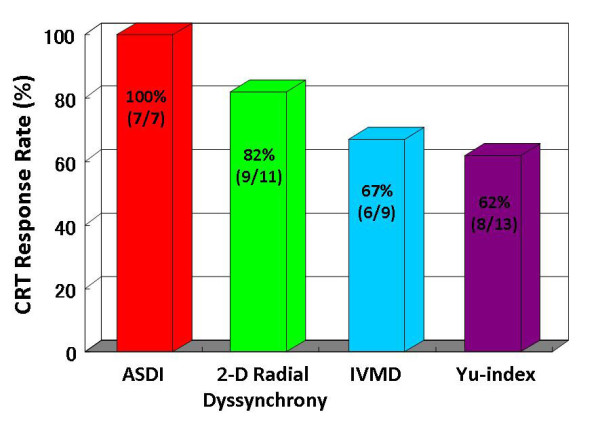
Bar graphs showing comparison of rates of response to cardiac resynchronization therapy (CRT). Patients with strain dyssynchrony index with area tracking (ASDI) ≥ 3.8% showed a response rate of 100% (7/7), those with 2-D radial dyssynchrony determined by speckle tracking strain ≥ 130 msec a rate of 82% (9/11), those with interventricular mechanical delay (IVMD) 40 ≥ msec a rate of 67% (6/9), and those with a Yu index ≥ 32 msec a rate of 62% (8/13) CRT.